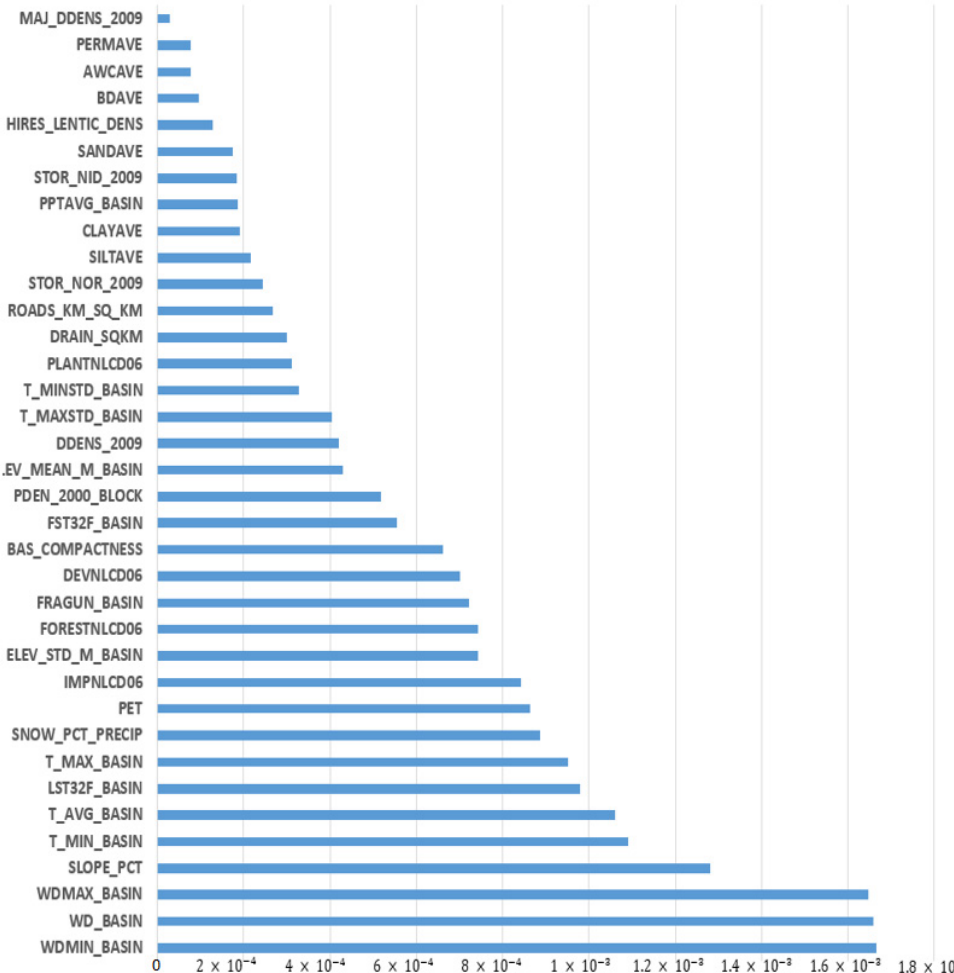
Figure 4. Predictor variables of the shape parameters (with associated importance) for Appalachian Highland. Description of predictor variables is provided in Appendix A.